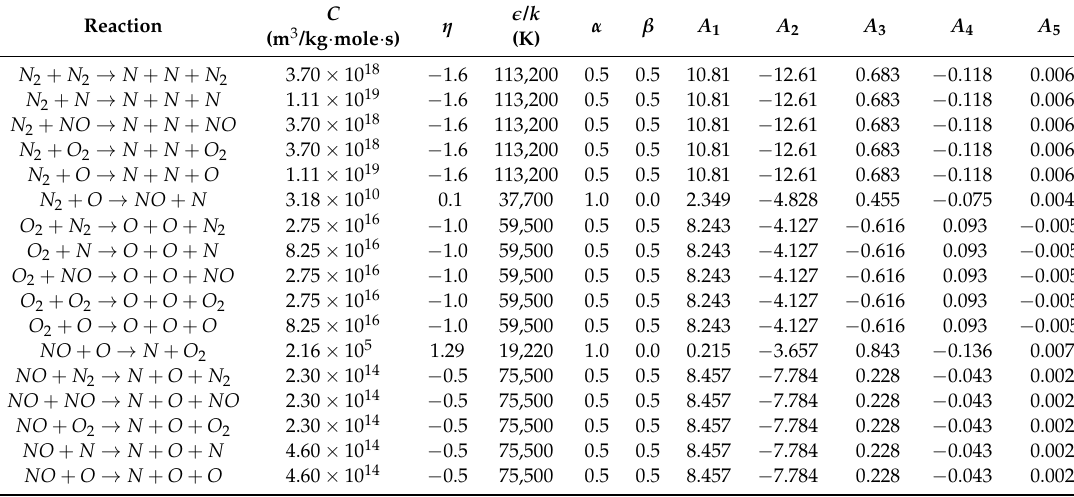
Table 2. Thermochemistry model reactions.